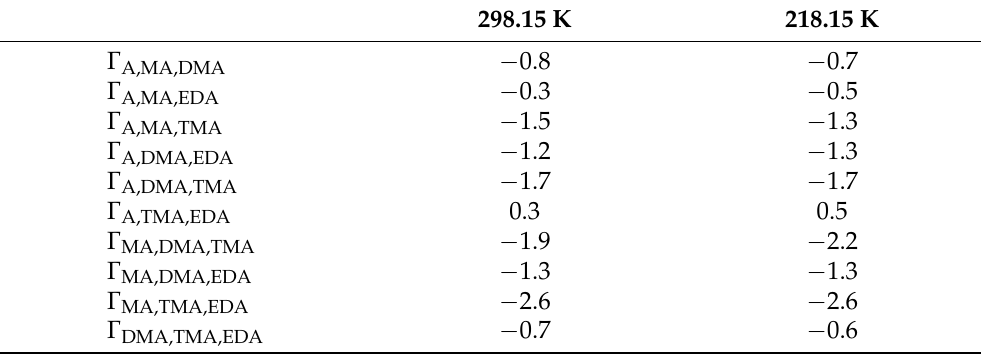
Table 2. Calculated tri-base synergy factors (at 298.15/218.15 K, 1 atm) of the mixed (SA) 3 (base) 3 clusters at the DLPNO-CCSD(T 0 )/aug-cc-pVTZ// ω B97X-D/6-31++G(d,p) level of theory using the quasi-harmonic approximation. Data are presented in in kcal mol − 1